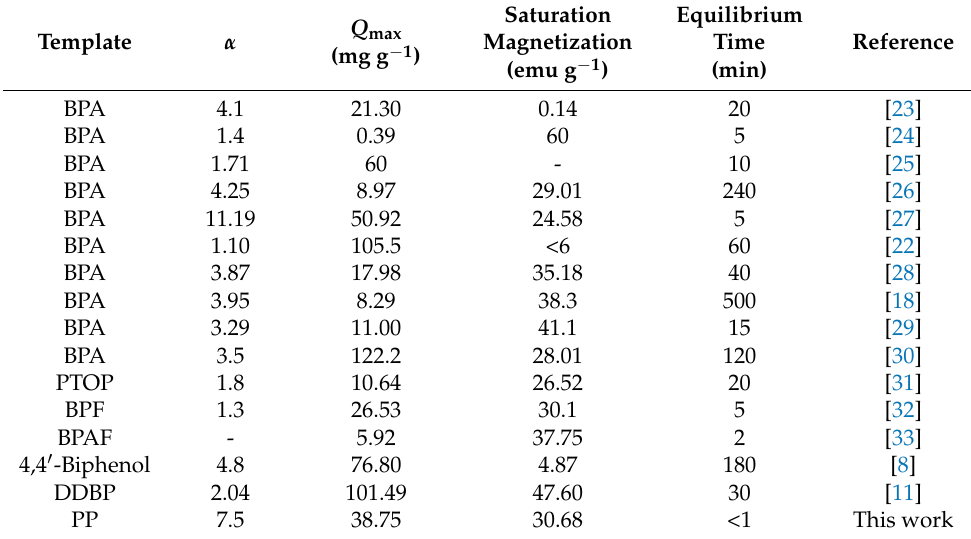
Table 2. Comparison of different magnetic molecular imprinting adsorbents for BPA.